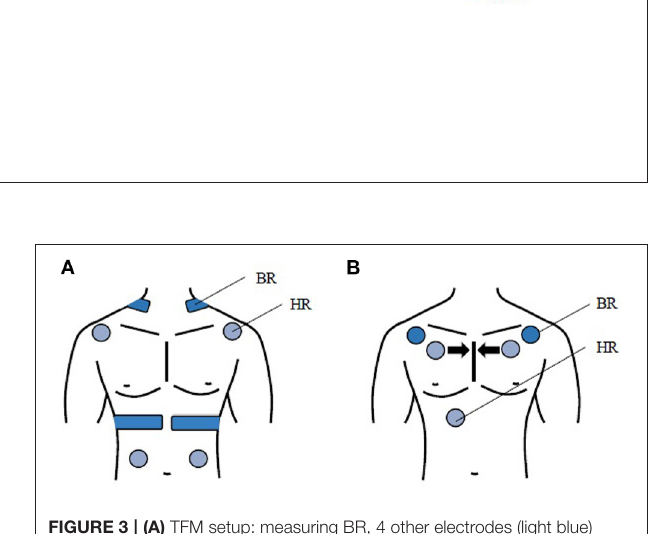
FIGURE 3 | (A) TFM setup: measuring BR, 4 other electrodes (light blue) measuring HR, (B) SP setup: 2 electrodes (dark blue) measuring BR, 3 electrodes (light blue) measuring HR. During the study the electrodes of the SP are placed closer after every iteration, which is schematically shown with the black